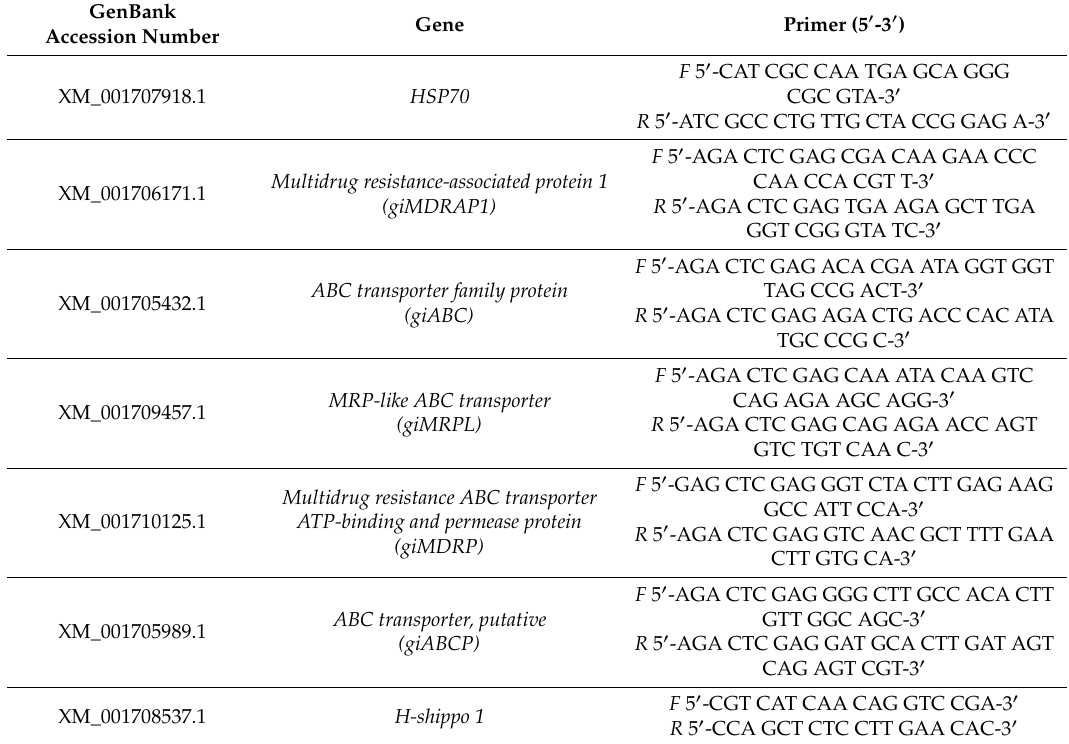
Table 4. Specific primers to assess the e ff ect of ASA on the expression level of HSP70 and MDRs by